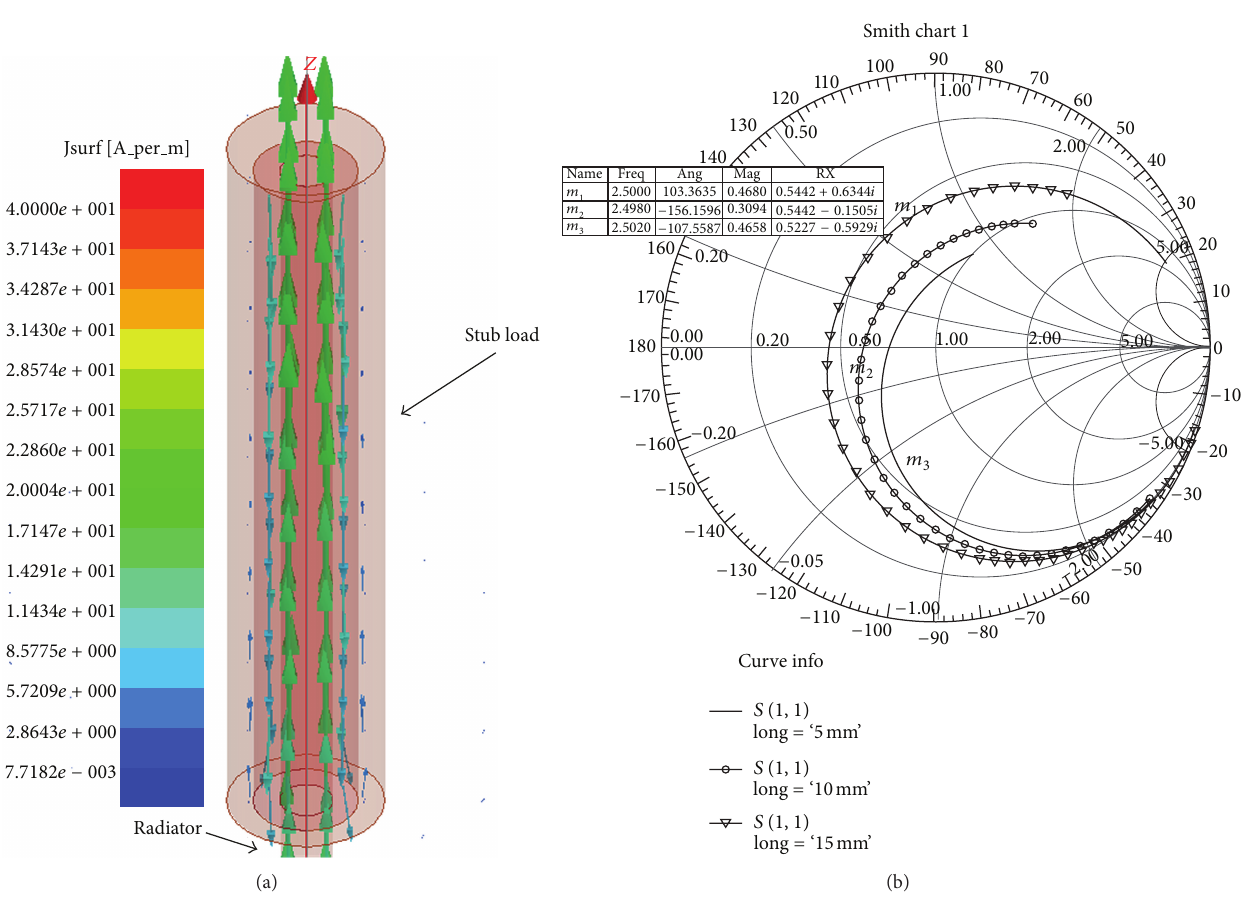
the stub radius is 1 mm, the resonance is around 2.3 GHz, and the bandwidth (considering a 𝑆 11 ≤ − 10 dB) is about 80 MHz. On the other hand, when the stub radius is 3.0 mm, the resonance is close to 1.5 GHz, but the bandwidth is around 30